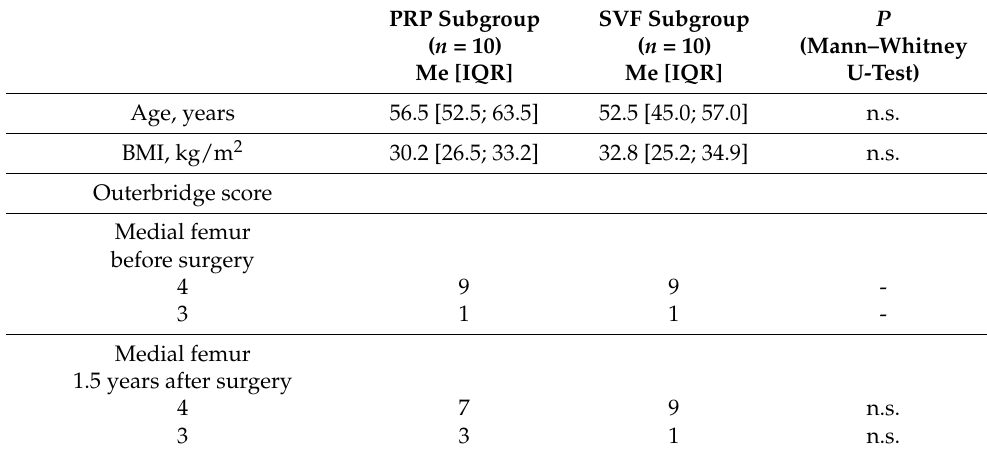
Table 1. Clinical and functional characteristics of patients with OA subjected to HTO therapy with post-surgery injections of PRP or SVF prior to and in the course of